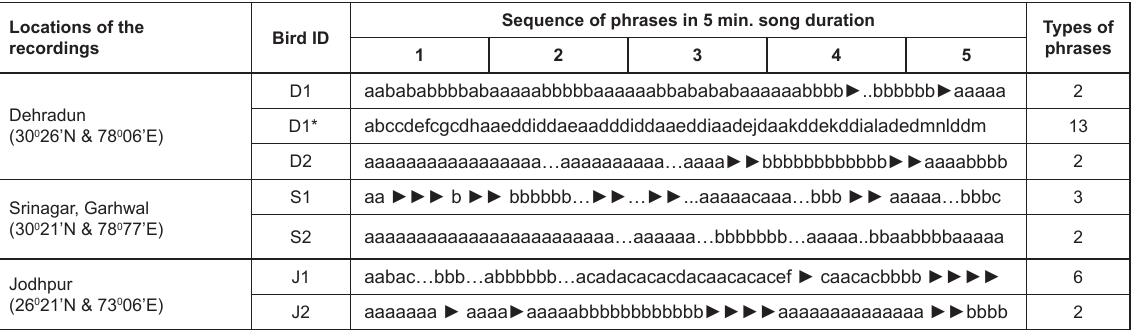
Table 2. Some examples of sequence of phrases in song bouts in the Indian Robin. For example, bird D1 used two types of phrases i.e. a and b, alternatively in 5 minutes long bout, and bird J1 used six types of phrases almost randomly. Locations of the